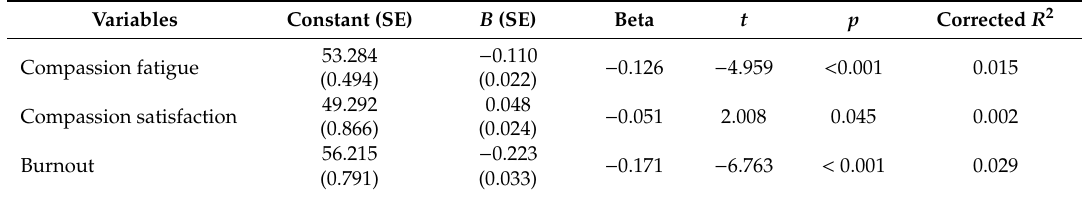
Table 4. Simple linear regression coe ffi cients for the physical component of HRQoL. Nursing professionals ( n =